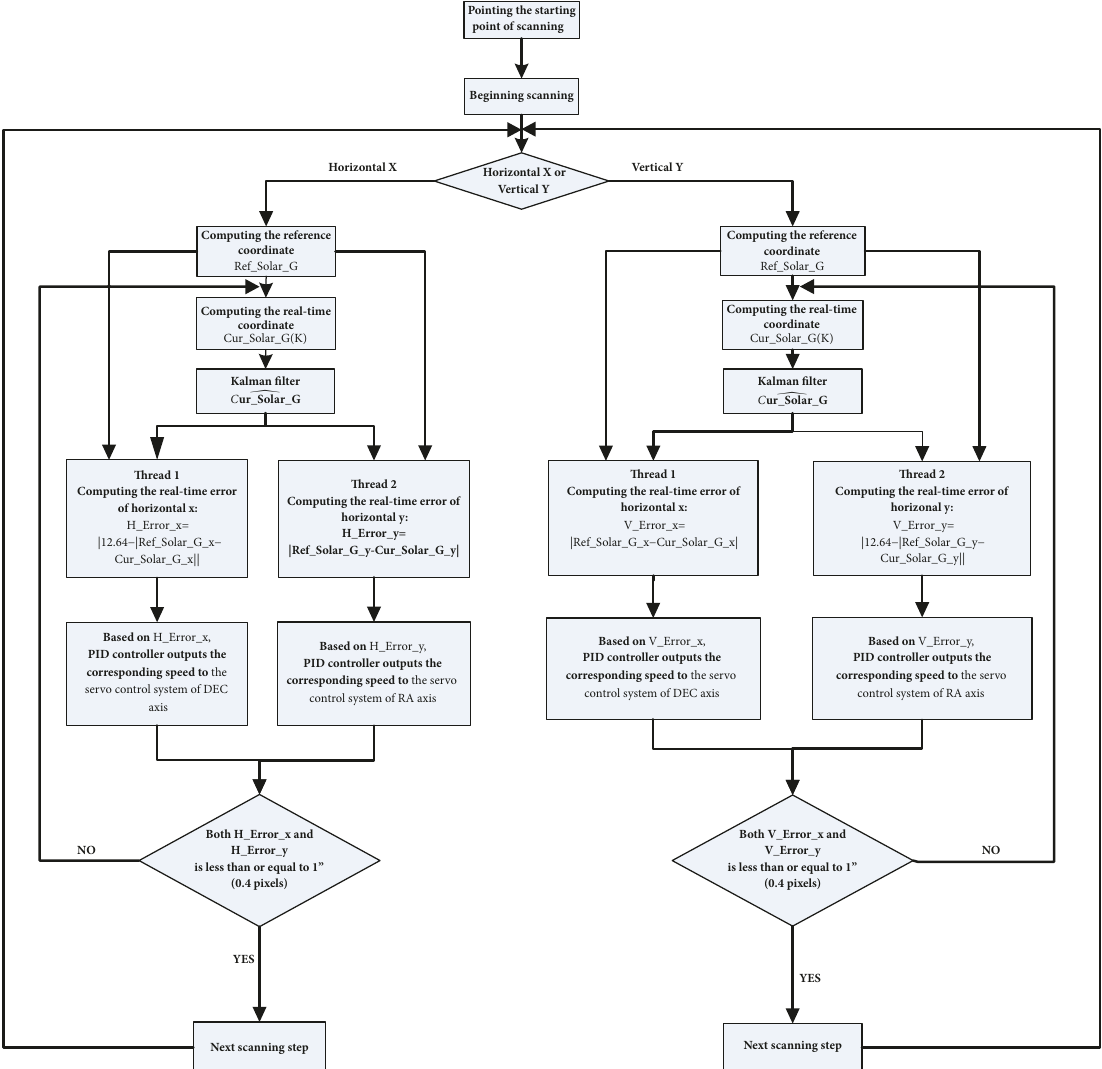
Figure 5: The program flow chart of our proposed scanning